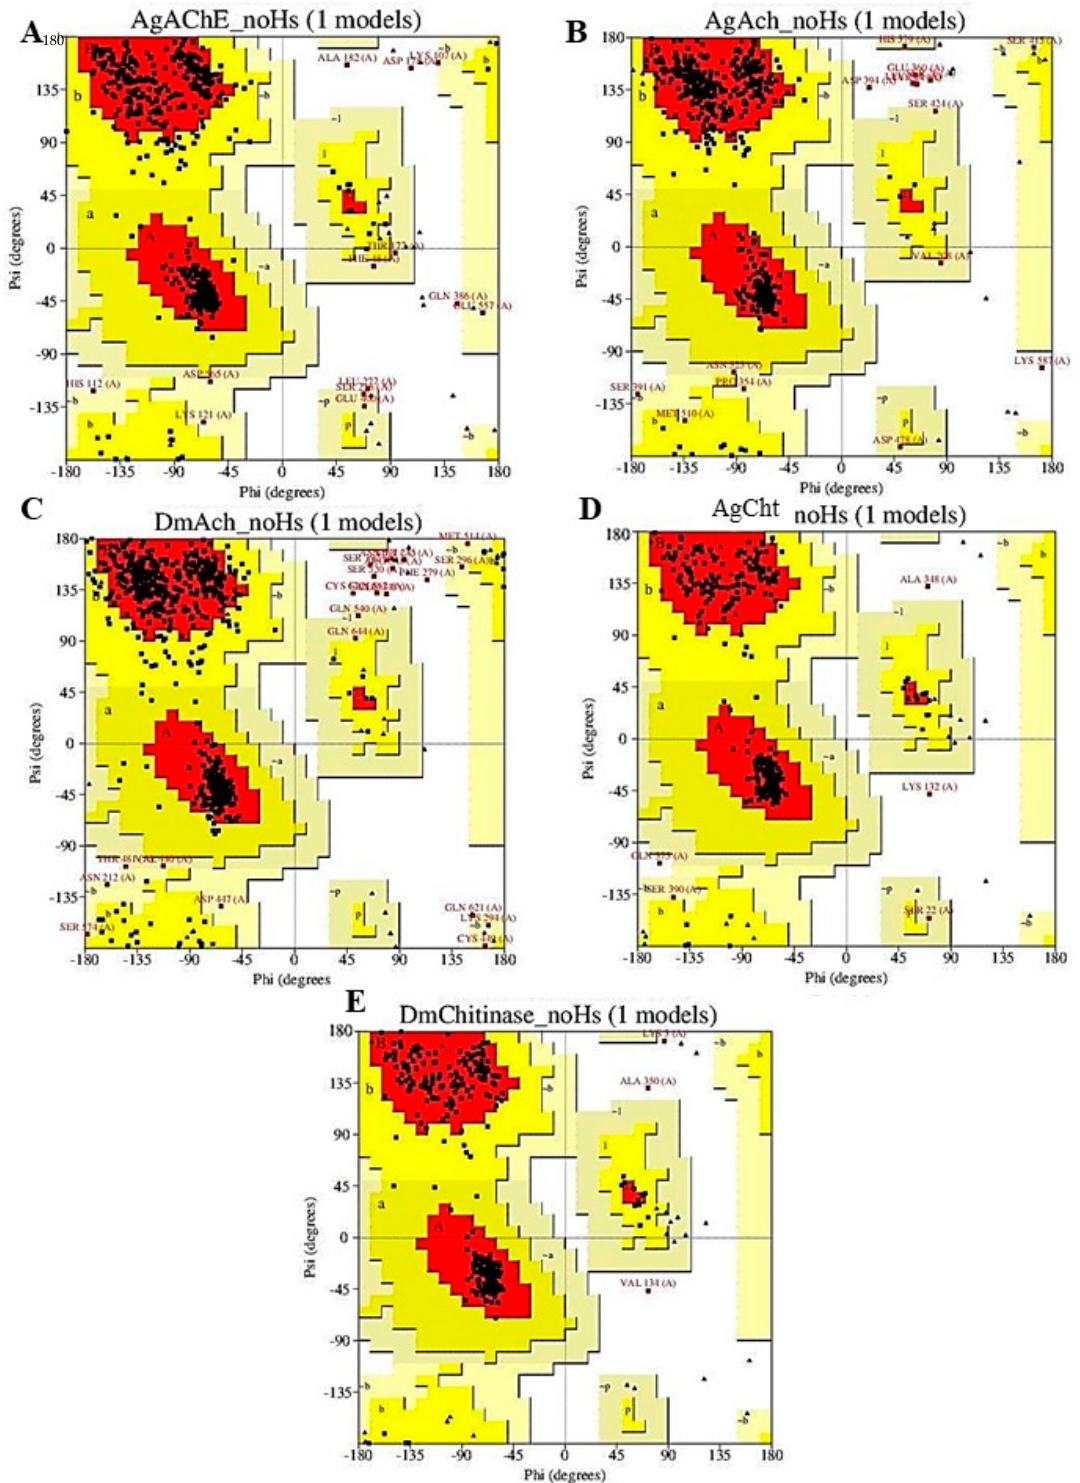
Figure 5. Ramachandran graphs of the homology models generated for A. gossypii and D. melanogaster enzymes. The colored regions represent the permitted and favored regions of the secondary structures and the white regions represent the prohibited regions. ( A ) A. Gossypii -AChE, ( B ) A. gossypii -nAChR, ( C ) D. melanogaster -nAChR, ( D ) A. gossypii -Cht ( E ), and D. melanogaster -Cht.